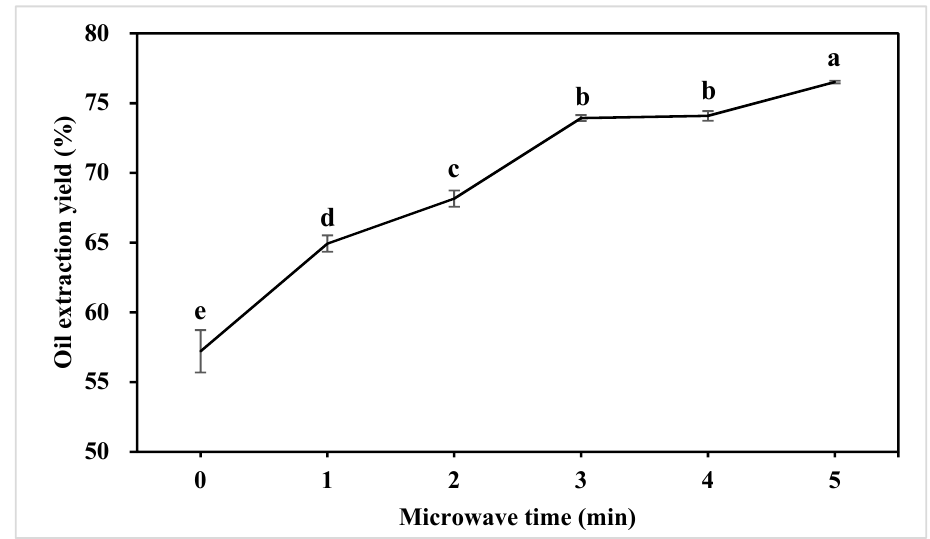
Figure 1. Effect of microwave pretreatment on the oil extraction yield. Different characters (a–e) on top of the line indicate significant ( p < 0.05) differences among samples with different treatment times.